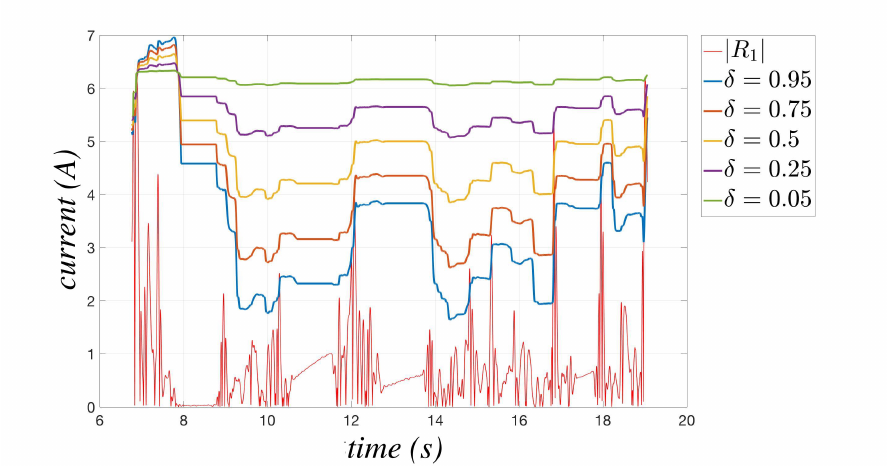
Figure 5. Behavior of the model error ˆ m err ,1 ( t ) in the unsteady states for different values of